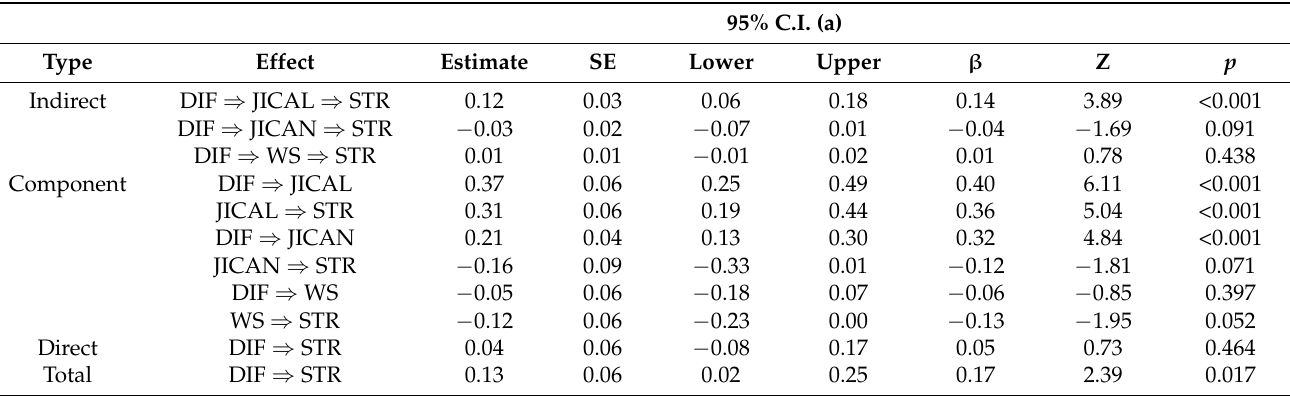
Table 5. Indirect and total effects of predictors on